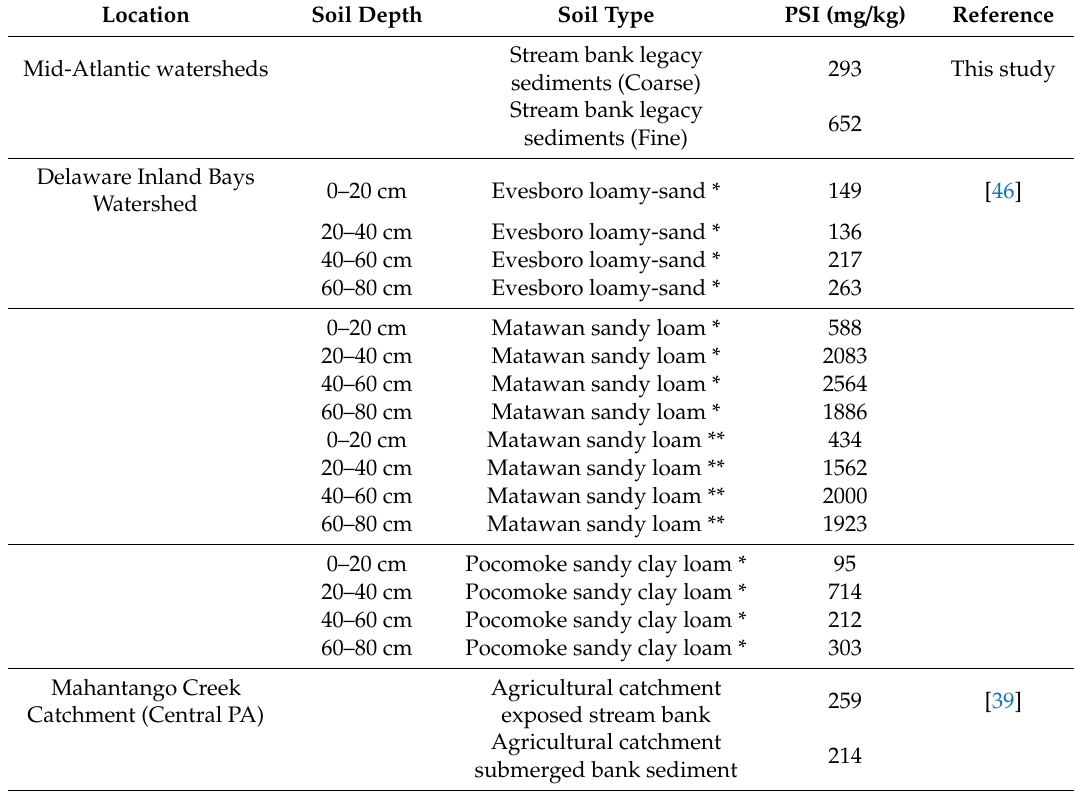
Table 2. PSI (mg / kg) values for agricultural and streambank soils in the Mid-Atlantic Region. Location Soil